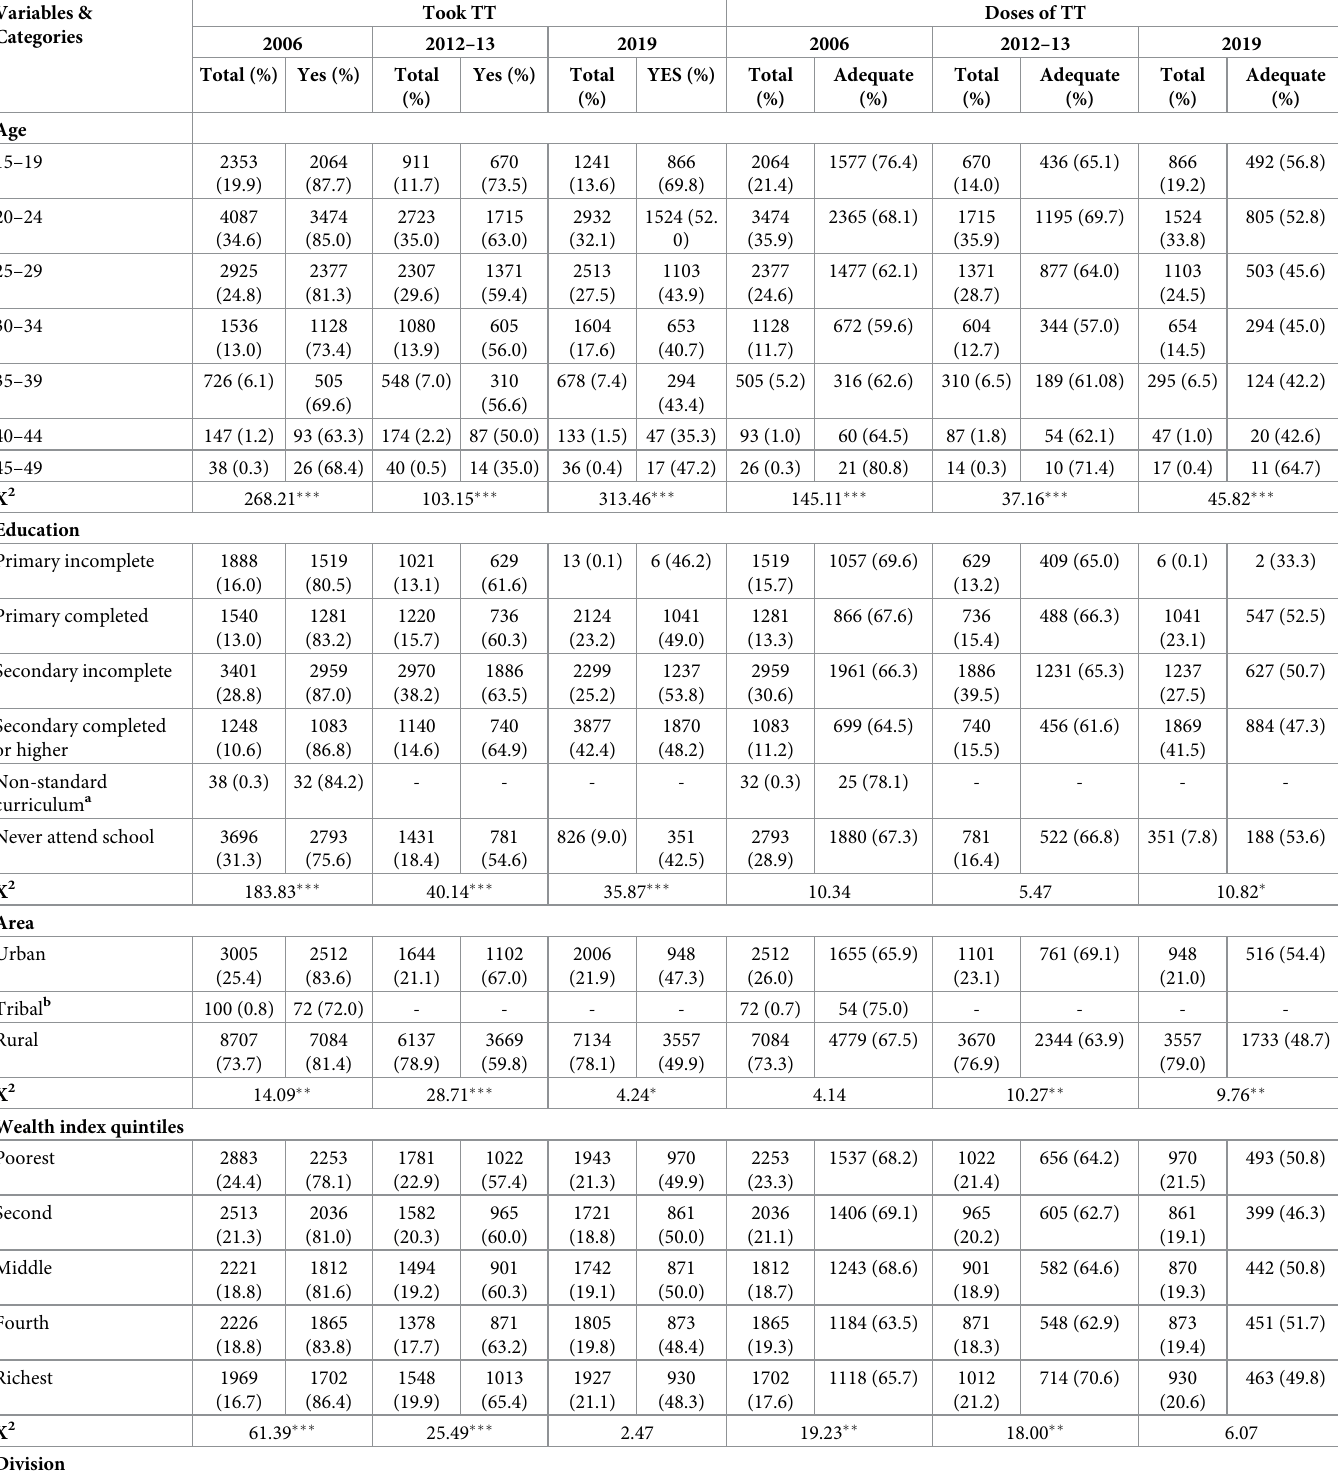
Table 1. Prevalence of taking tetanus toxoid among pregnant women aged 15–49 years in Bangladesh (2006–2019). Variables &